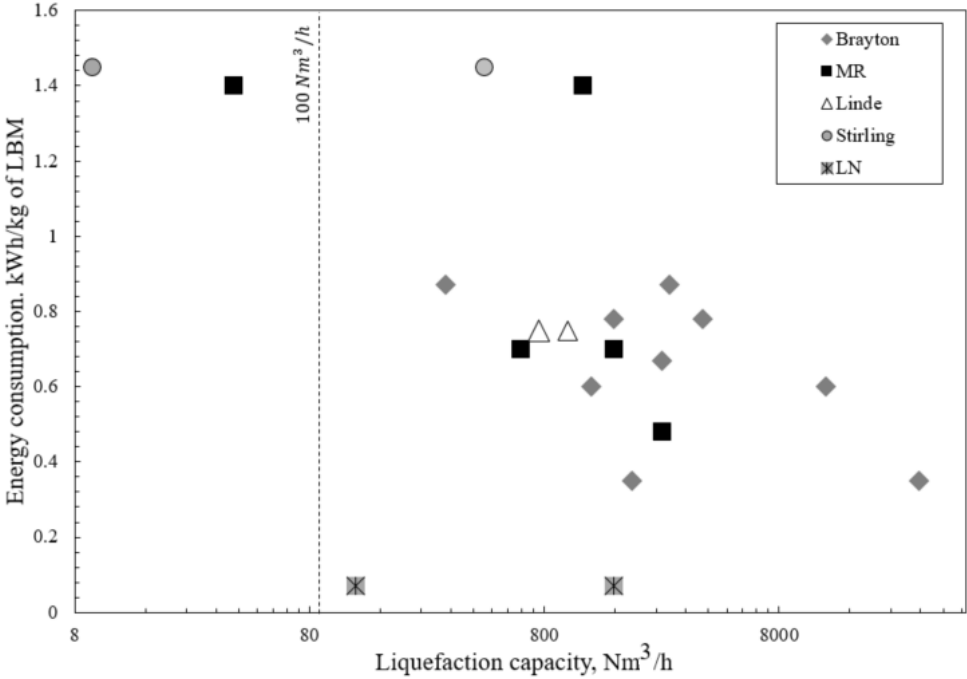
Figure 3. Summary of the availability for biomethane liquefaction by capacity and energy consump- tion with respect to liquefaction technology